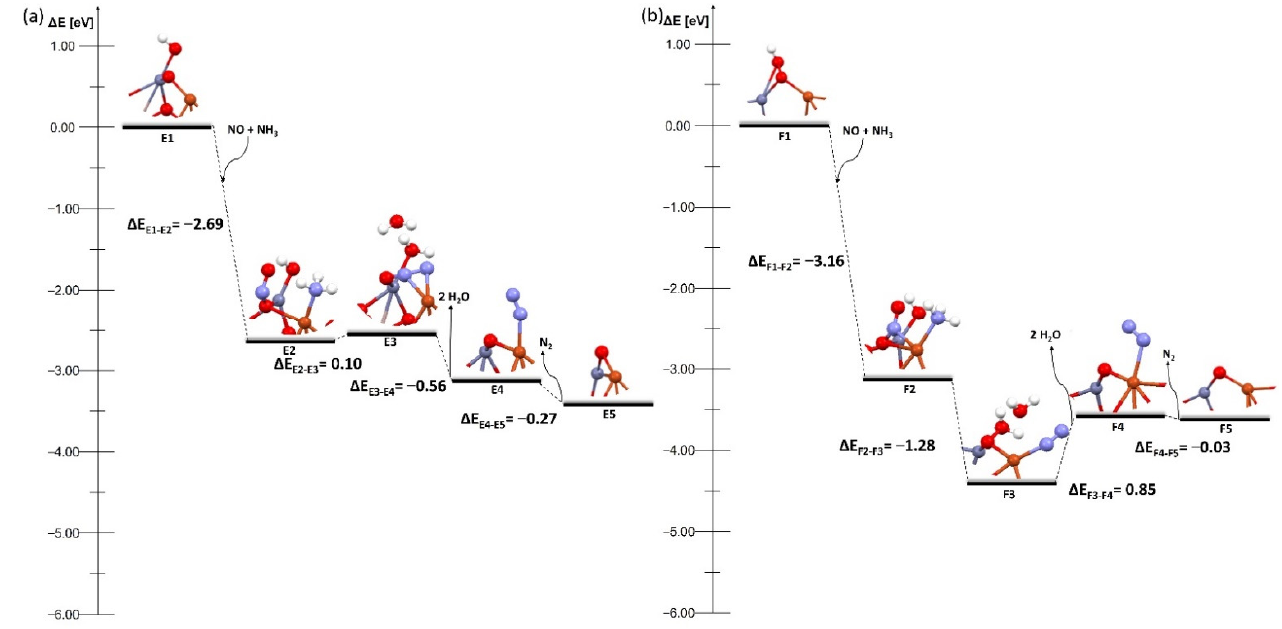
Figure 6. Energy diagram of proposed mechanism of deNOx in the Cu–O–Zn dimer supported on ( a ) bimetallic dimer on FAU and ( b ) bimetallic dimer on MFI with OH group on Zn on both zeolites. The first pathway is represented by a system with a bridged OH group (Figure 4).